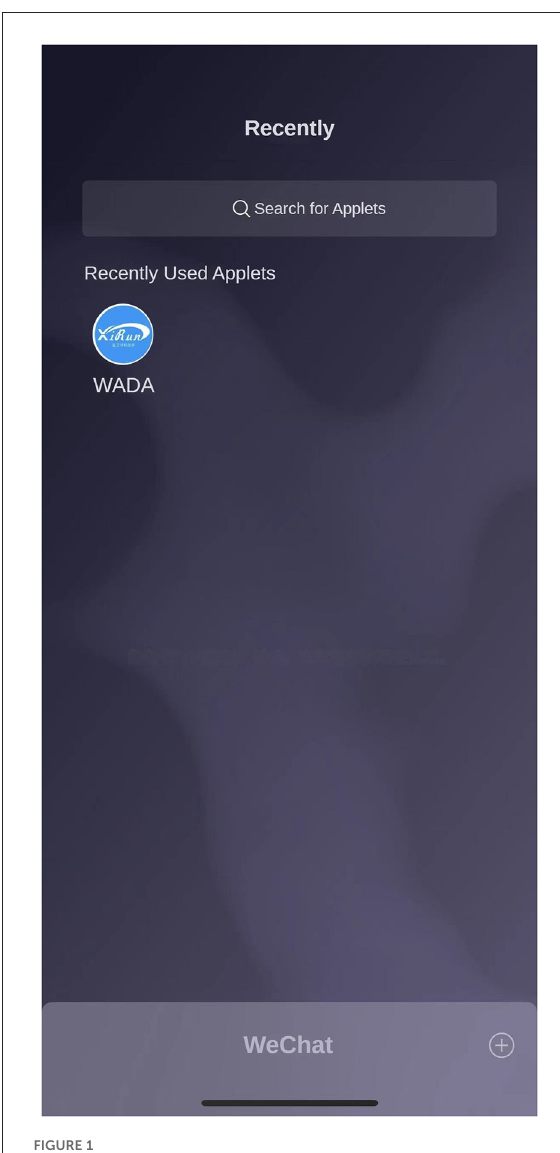
FIGURE1 Applet opening interface. Patients can search for the WADA and use it by scrolling down on the main screen of WeChat without the need to download additional applications. It takes up little memory and is very convenient.